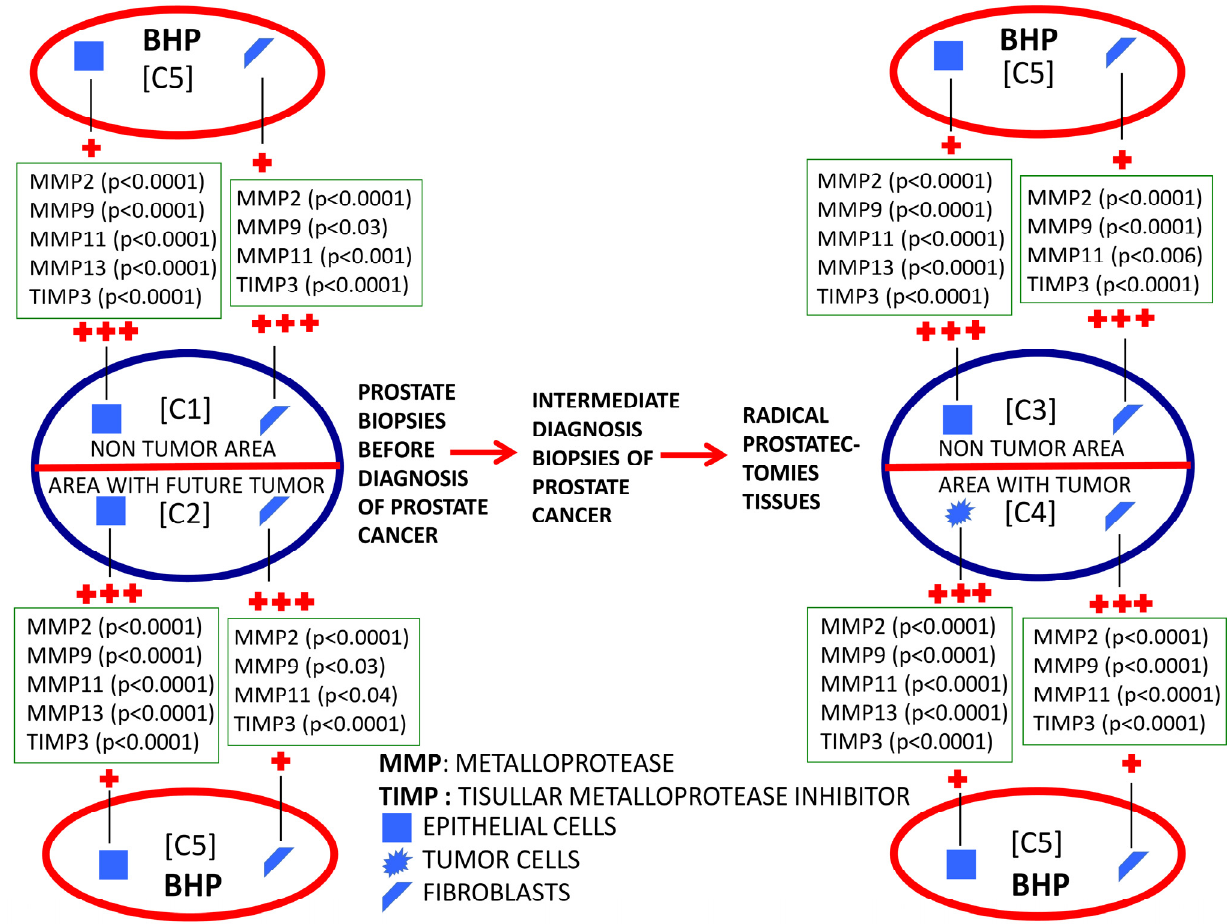
Figure 4. Schematic comparative study of the expression of MMPs and TIMP-3 by epithelial cells and by fibroblasts from benign prostatic hyperplasia (BHP), benign prostate biopsies before the diagnosis of prostate cancer (non-tumor zones and zones with future tumor), and from paired zones from prostatectomies by prostate cancer (non-tumor zone and zone with tumor). +: lower expression; +++: higher expression.